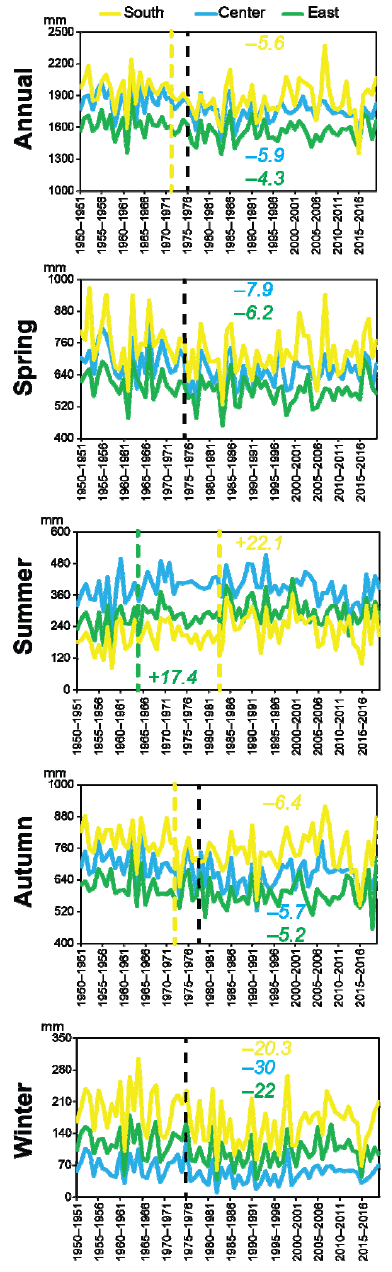
Figure 7. Temporal variation of annual and seasonal rainfall for the southern regions of the country (South, Center, and East), according to the Pettitt test. The rupture years are indicated by the vertical dashed lines. On their right sides appear the corresponding rates of change. The ruptures in black are those which are identical to several regions. Table 4. Deviations (%) of the decadal annual and seasonal averages of rainfall compared to their interannual means for the southern regions of the country (Center, East, and South) .